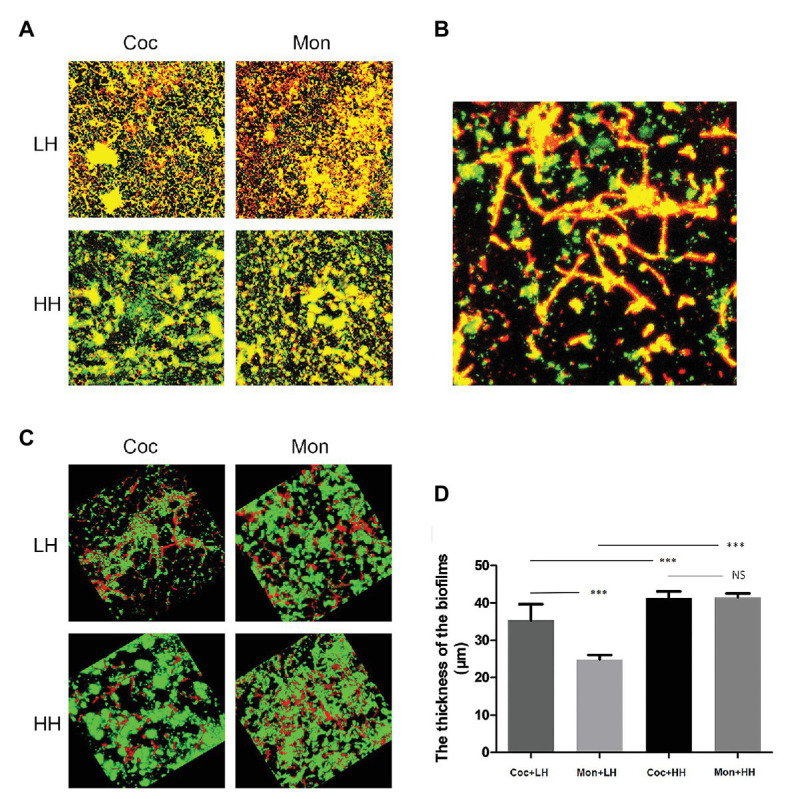
Epifluorescence images of biofilms in low-heme and high-heme environments. Porphyromonas gingivalis single-species biofilm and P. gingivalis-C. albicans dual-species biofilm were cultured for 24 h. The biofilms were stained with the LIVE/DEAD staining system. Red cells (stained with propidium iodide) are considered dead, while live cells remained green (stained with SYTO9). (A) 2D images of biofilms after 24 h. (B) Dead C. albicans in dual-species biofilm under a low-heme environment. (C) 3D images of biofilms after 24 h. (D) The thicknesses of biofilms were measured and analyzed by ZEN Lite Microscopy Software. ***p < 0.001; NS p > 0.05. LH, low heme; HH, high heme; Coc, coculture; and Mon, monoculture.